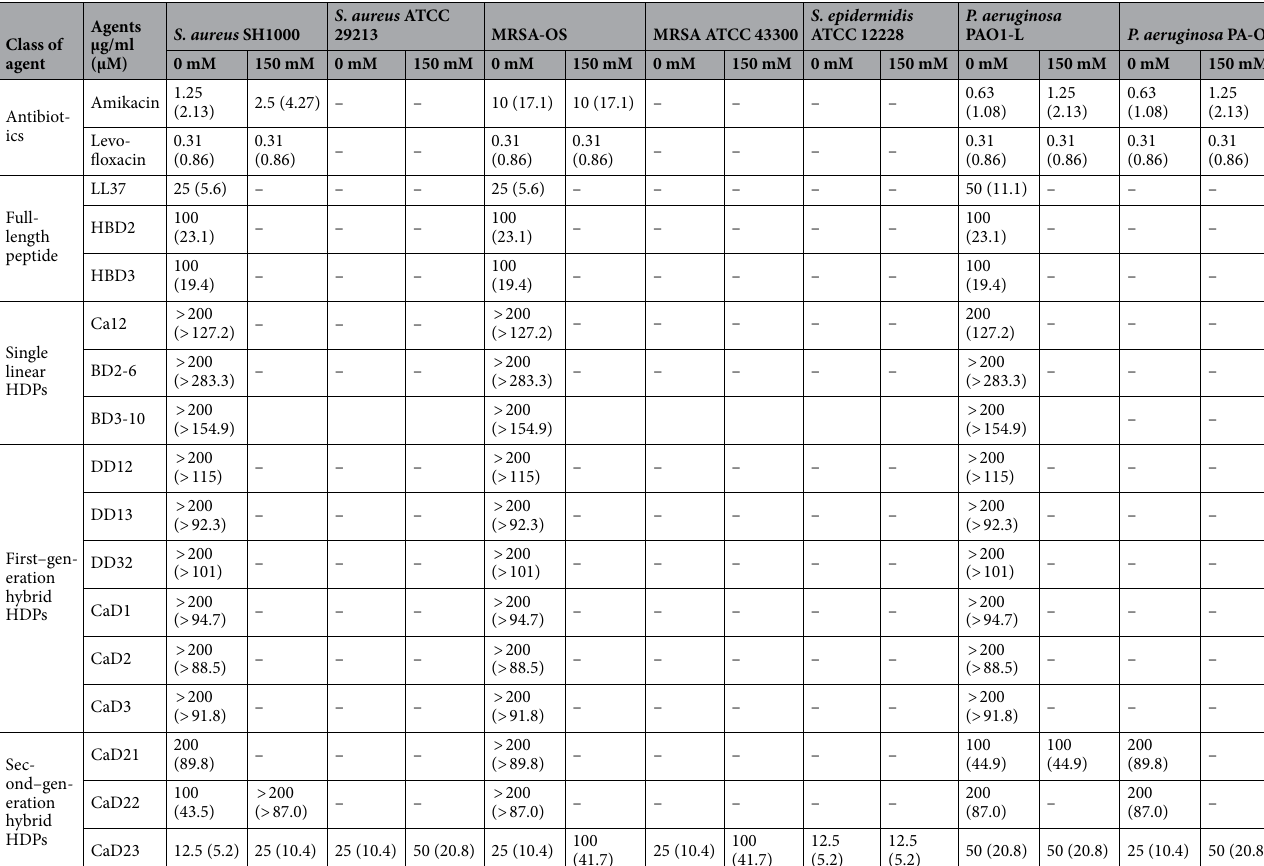
Table 2. A summary of the minimum inhibitory concentrations (MICs) of various antibiotics and synthetic human-derived hybrid host defense peptides. All experiments were performed in full-strength cationic